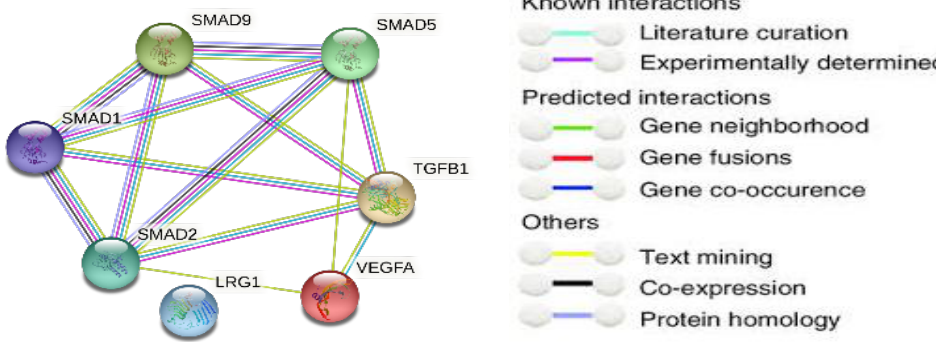
Figure 1. Network protein–protein interaction analysis for TGFβ and Smad proteins as presented by the STRING database.